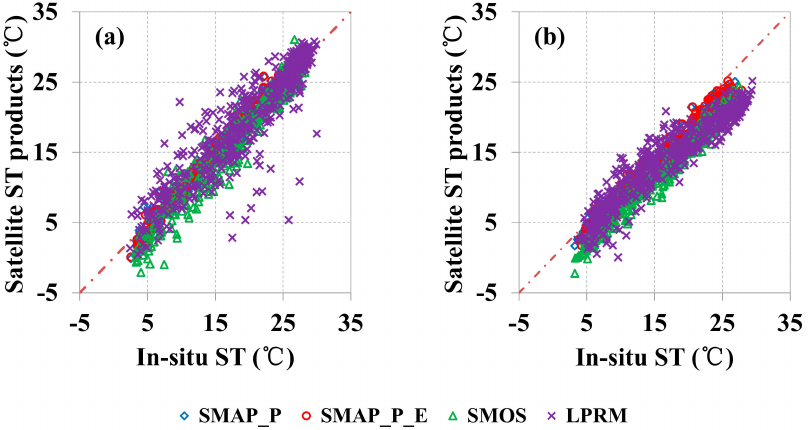
Figure 7. Scatterplot comparison of the station-averaged surface temperature and satellite surface temperature ancillary data for the ( a ) LWW and ( b ) REMEDHUS network